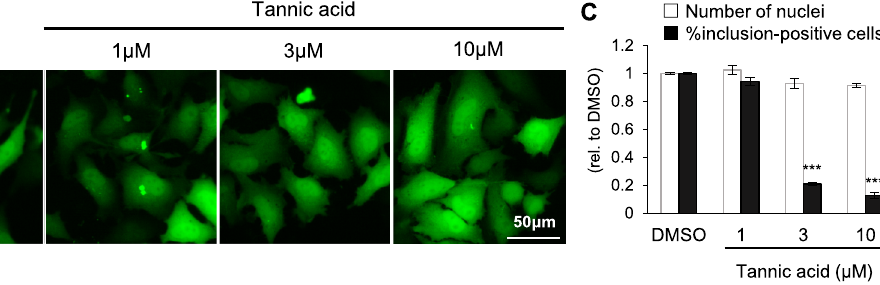
Figure 3. Cell-based screening of αSyn aggregation inhibitors. ( A ) Quantification of the number of nuclei (white bars) and the percentage of cells containing obvious αSyn-EGFP inclusion bodies (black bars), standardized by those of cells treated with DMSO. Concentration of the drugs are indicated at the right. The numbers under the graph correspond to the numbers in Table 1. Data are shown as the mean ± SEM of three independent wells (n = 3; * P < 0.05; one-way ANOVA with the Dunnett test compared with the DMSO control). ( B ) Representative images of tannic acid-treated HeLa cells. Cells were transfected with pCMV αSyn-EGFP, followed by treatment with αSyn PFF and the indicated concentrations of tannic acid. ( C ) Quantification of the number of nuclei (white bars) and the percentage of cells containing obvious αSyn-EGFP inclusion bodies (black bars) in B standardized by those of cells treated with DMSO. Data are shown as the mean ± SEM of three independent wells (n = 3; * P < 0.001; one-way ANOVA with the Dunnett test compared with the no tannic acid